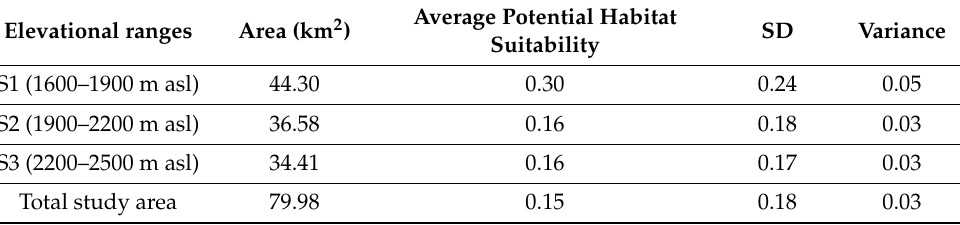
Table 5. Results for area (km 2 ) and mean suitability of potential habitat included in the polygon of the current